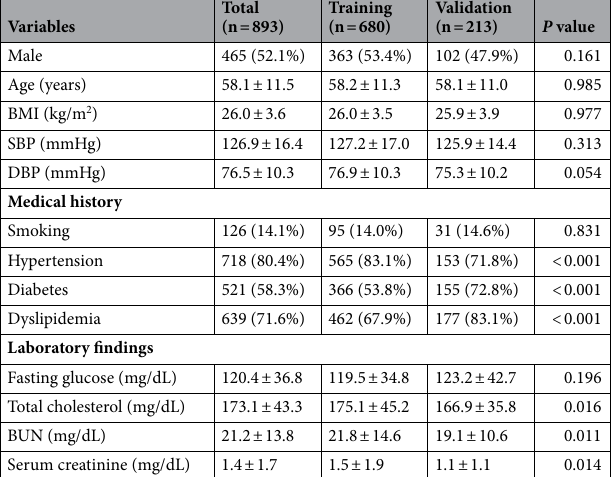
Table 1. Clinical characteristics of participants in the training and validation sets. Data are absolute participant numbers and percentages in brackets or means ± standard deviations. BMI body mass index, SBP systolic blood pressure, DBP diastolic blood pressure, BUN blood urea nitrogen.